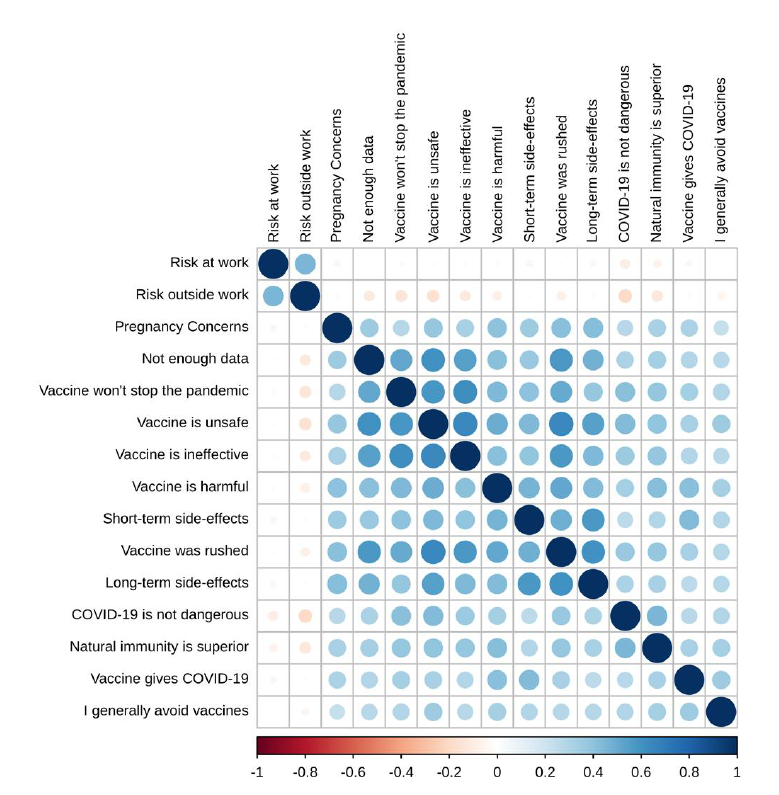
Figure A1. EFA Scree Plot.